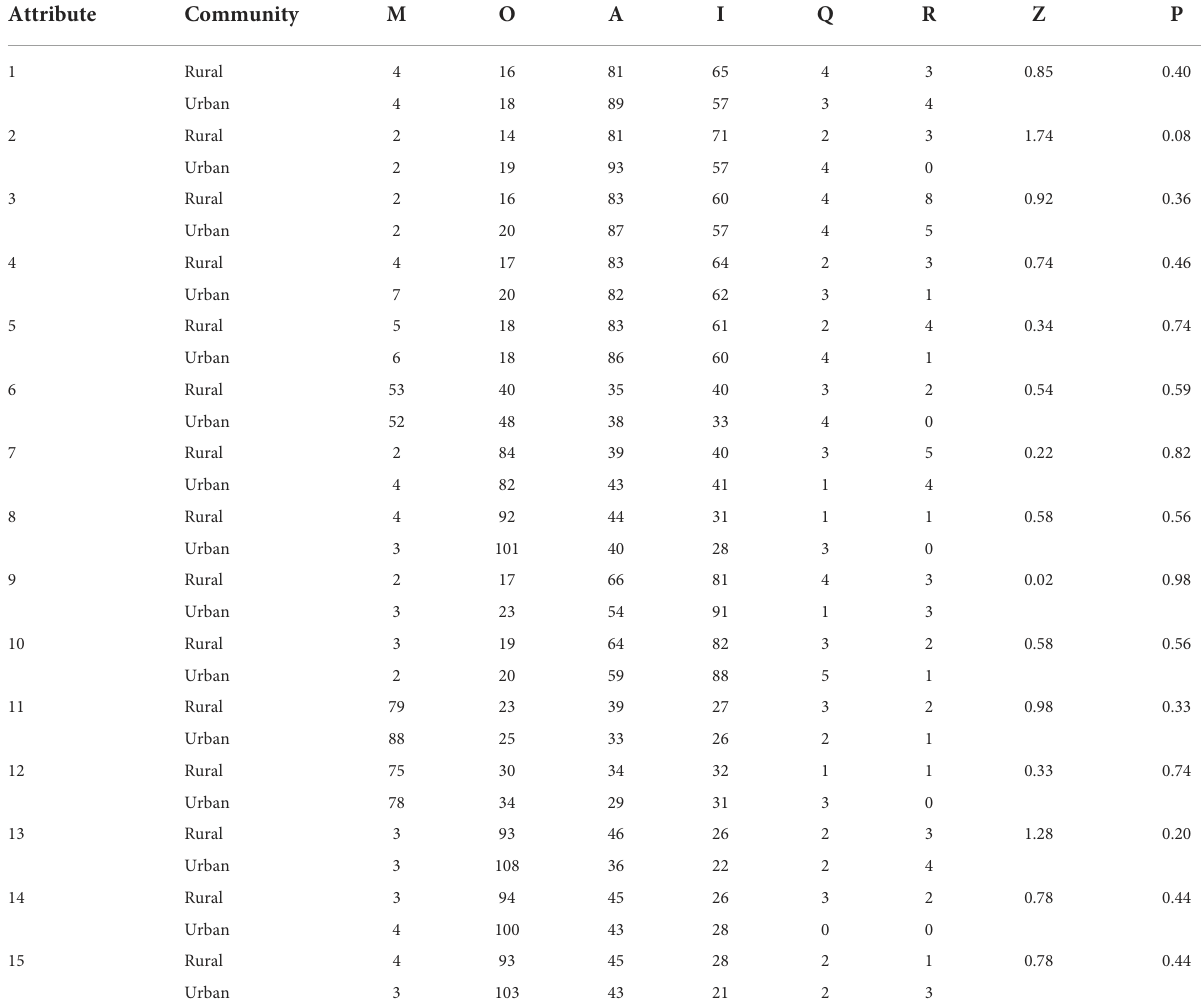
TABLE 6 The differences in telenursing demands between rural and urban communities.